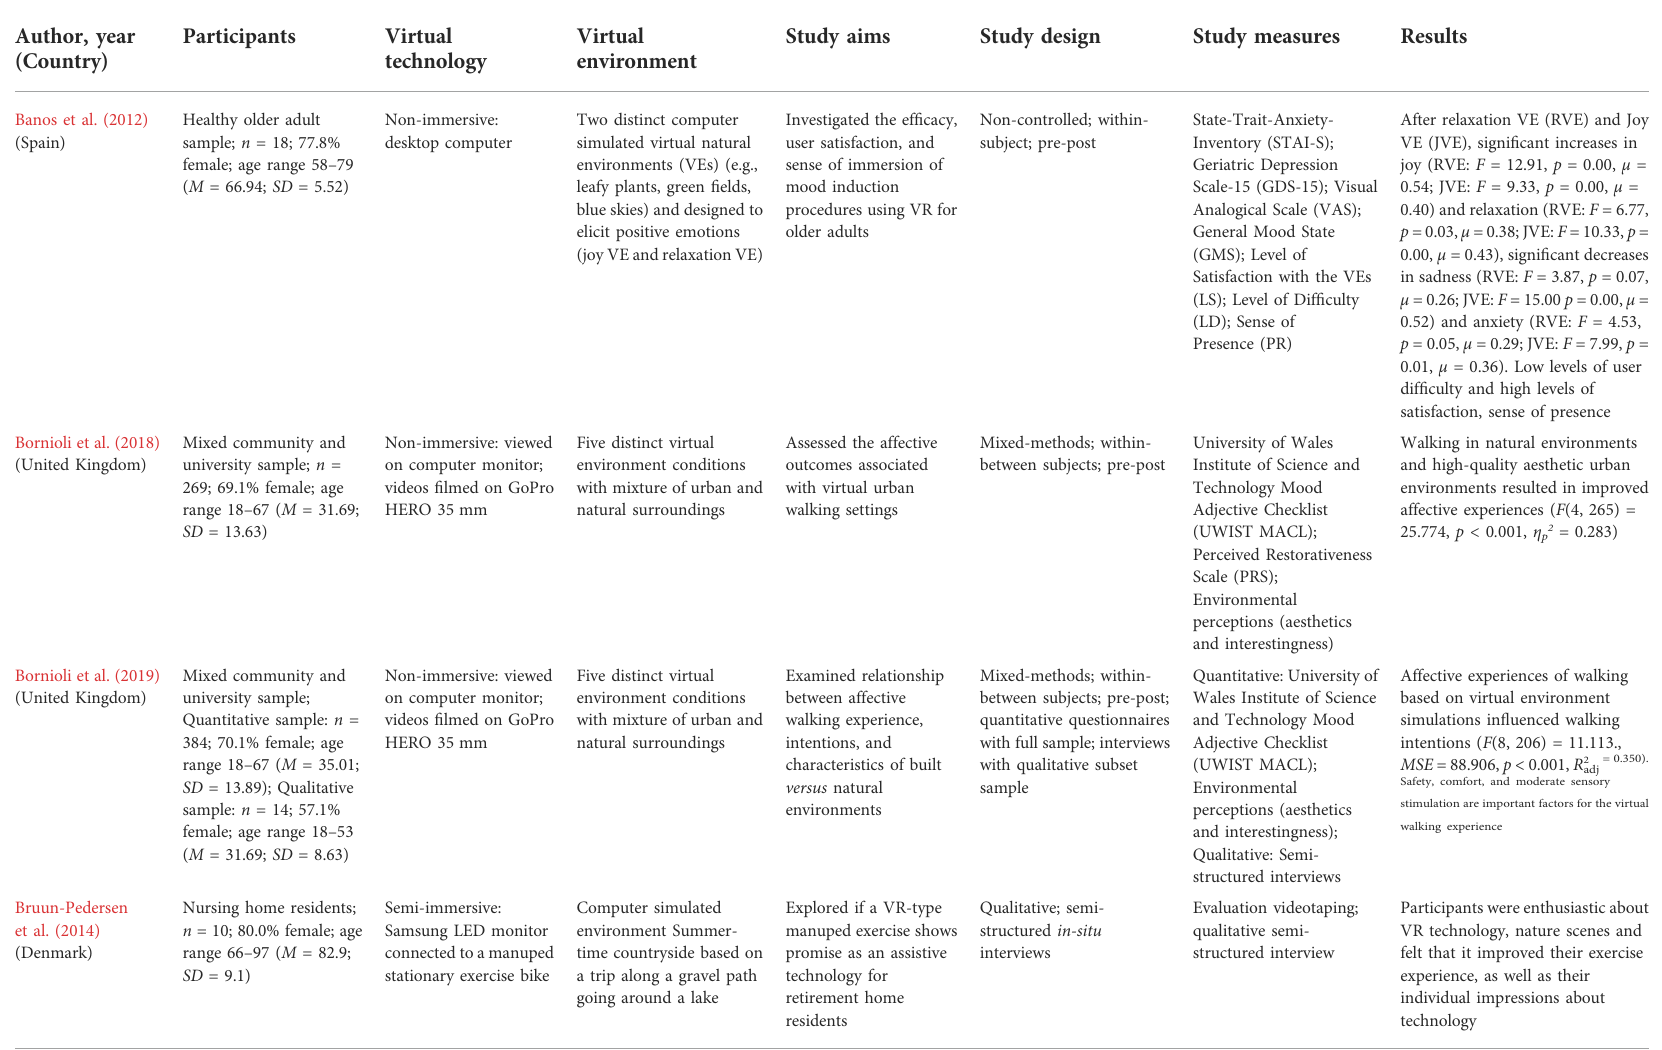
TABLE 2 Examples of empirical studies of nature-based VR interventions for older-adult mental health and